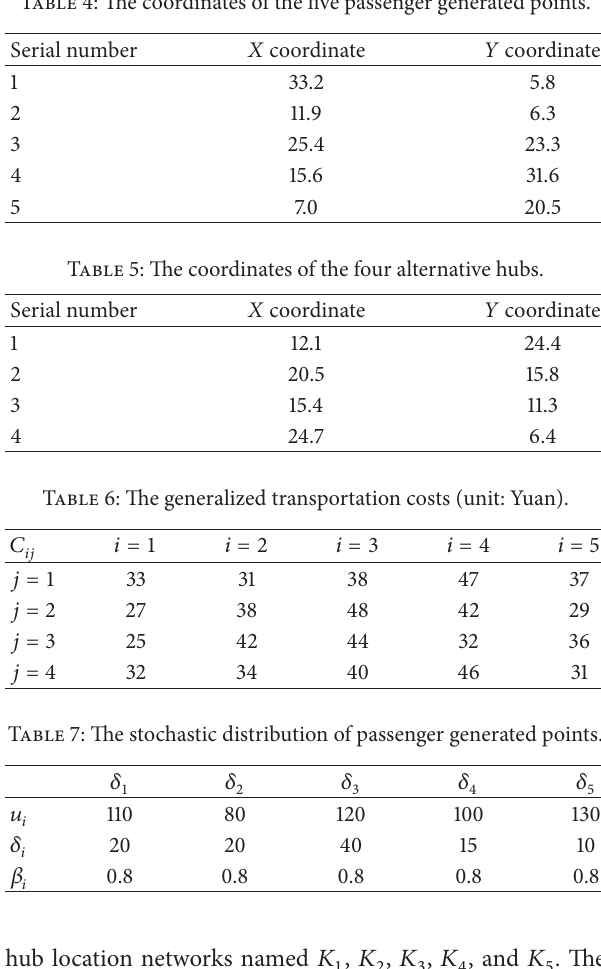
Table 4: The coordinates of the five passenger generated points.